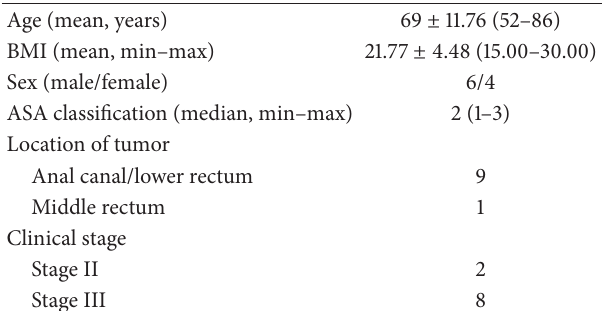
Table 1: Demographic